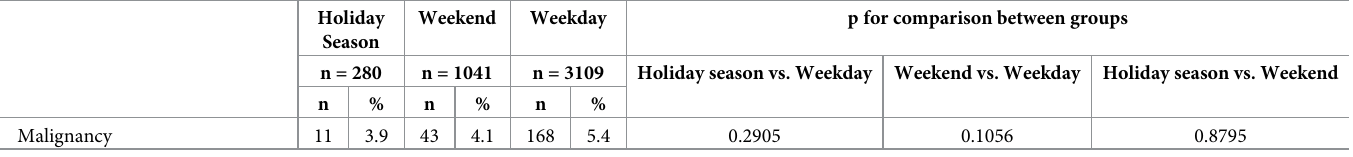
Continuous variables are compared using t-tests; categorical variables are compared using χ 2 tests. � Expressed as mean ± SD.